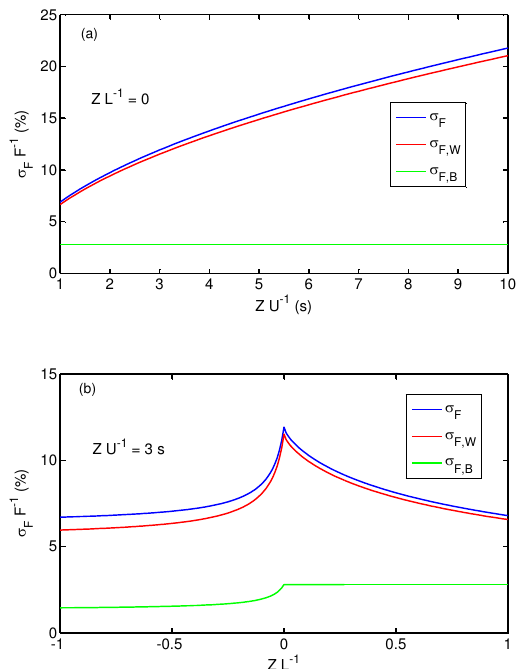
Figure 1. Dependence of relative flux random errors on (a) ZU − 1 and (b) ZL − 1 . Here we denote with Z the height above the displacement height, i.e. Z = z − d . The error estimates δ F , δ F,W and δ F,B were calculated according to Eqs. (A4), (A5) and (18),